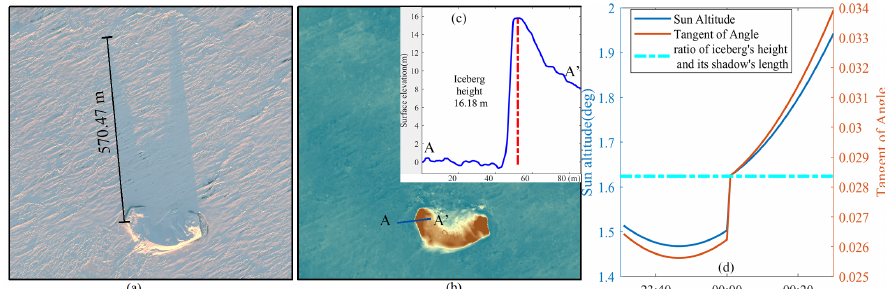
Figure 12. An iceberg was entrapped in landfast sea ice in sortie-1. ( a ) Orthomosaic imagery of the iceberg and its elongated shadow (570.47 m). ( b ) Surface elevation model of the iceberg and surrounding smooth sea ice. ( c ) The elevation profile of the blue line in ( b ), with a height of 16.18 m. ( d ) The evolution of solar altitude angle and its tangent ratio during the sortie-1 operated in polar day, and ratio of iceberg’s height and its shadow’s length. Note the leap of solar altitude before and after midnight, as a result of the discretization artefact in the approximation